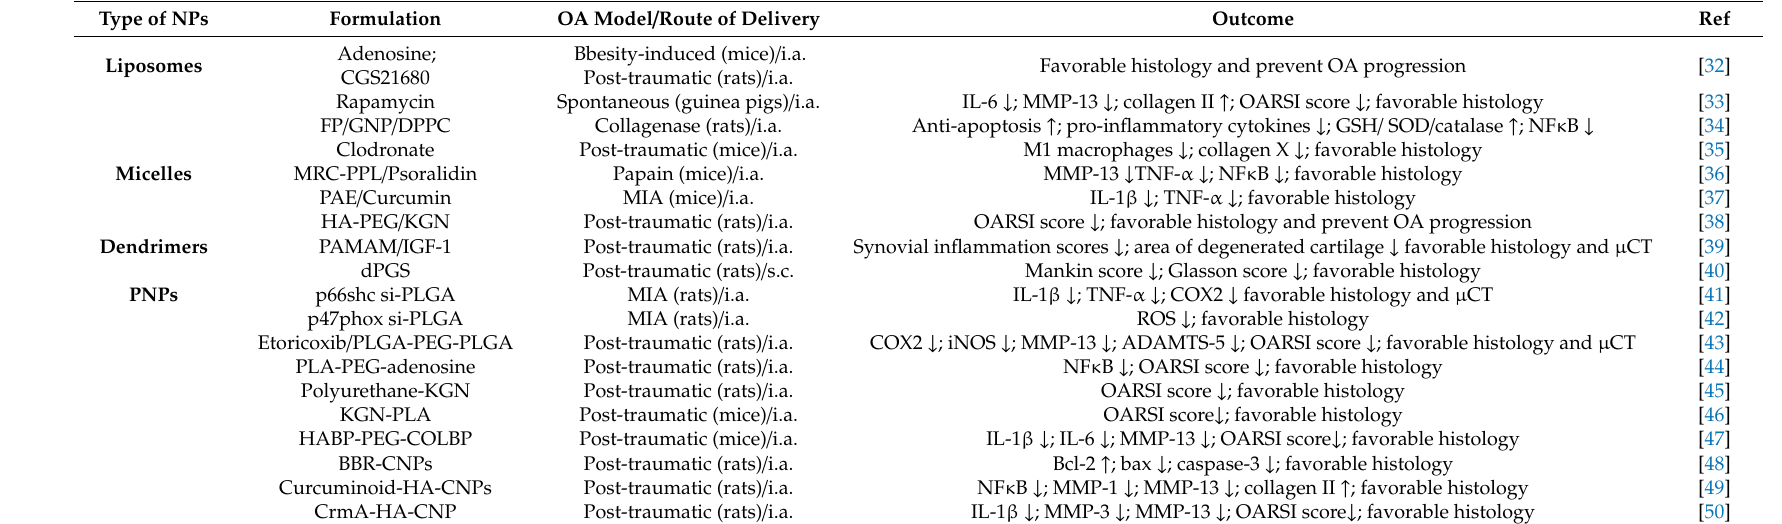
Abbreviations: BBR: Berberine chloride; BDMC: bisdemethoxycurcumin; CNPs: Chitosan nanoparticles; COLBP: Collagen binding peptide; dPGS: Dendritic polyglycerol sulfates; DPPC: dipalmitoyl phosphatidylcholine; FP: Fish oil protein; GNPs: Gold nanoparticles; GSH: Glutathione reductase; HA: Hyaluronic acid; HABP: Hyaluronic acid-binding peptide; HA / CS-CrmA: Hyaluronic acid-chitosan nanoparticles containing plasmid DNA encoding CrmA; i.a.: intra-articular; IGF-1: Insulin-like growth factor 1; KGN: Kartogenin; MIA: Monoidoacetic acid; MRC: MMP-13 responsive / Coll-II α 1 chain-binding peptide–CollB; OARSI: Osteoarthritis Research Society International; PAE: Poly( β -amino ester); PAMAM: polyamidoamine; PEG: poly (ethylene glycol); PNPs: Polymeric nanoparticles; PPL: Poly (2-ethyl-2-oxazoline)-poly ( ε -caprolactone); s.c.: subcutaneous; SOD: Superoxide